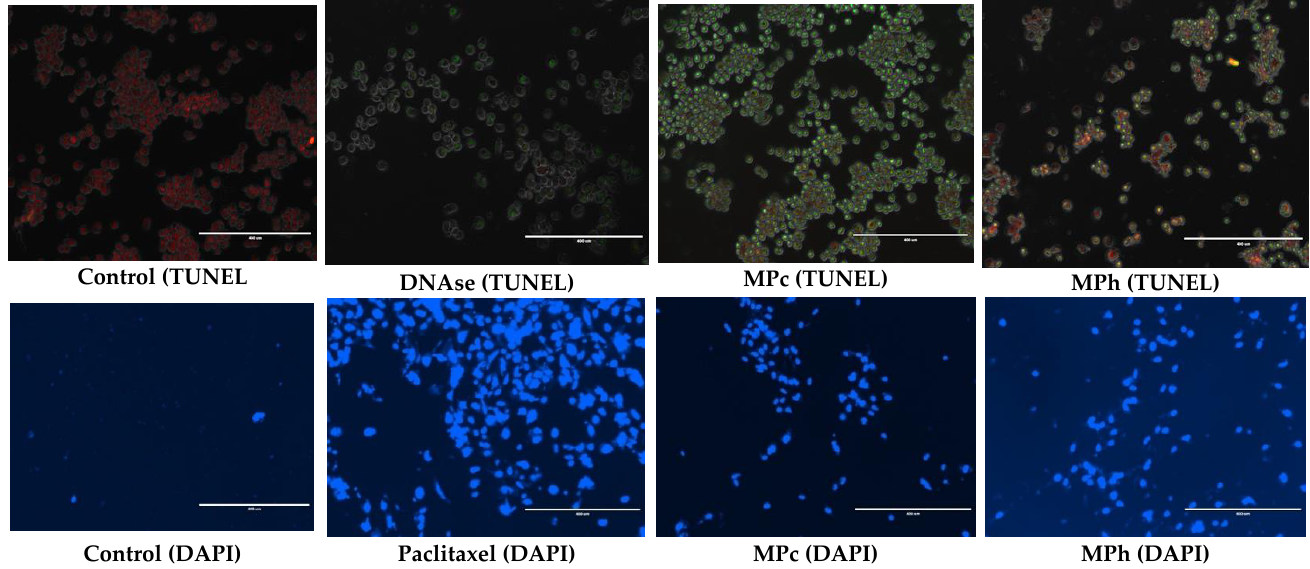
Figure 4. PC3 cells were treated with MPc and MPh extracts and DNAse (positive control) and stained with either Dead-End™ Fluorometric TUNEL or DAPI after 72 h of treatment. TUNEL: red fluorescence indicated healthy cells, while green fluorescence showed fragmented nuclear DNA.